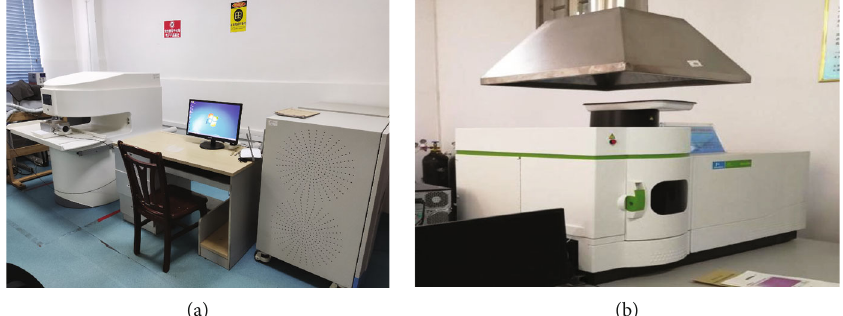
Figure 2: Test equipment. (a) Large aperture NMR imaging analyzer. (b) Inductively coupled plasma atomic emission spectrometer.